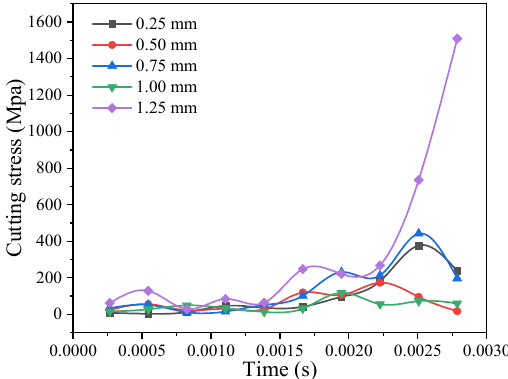
Figure 12. Comparison curve of the maximum cutting stress at different milling depths.